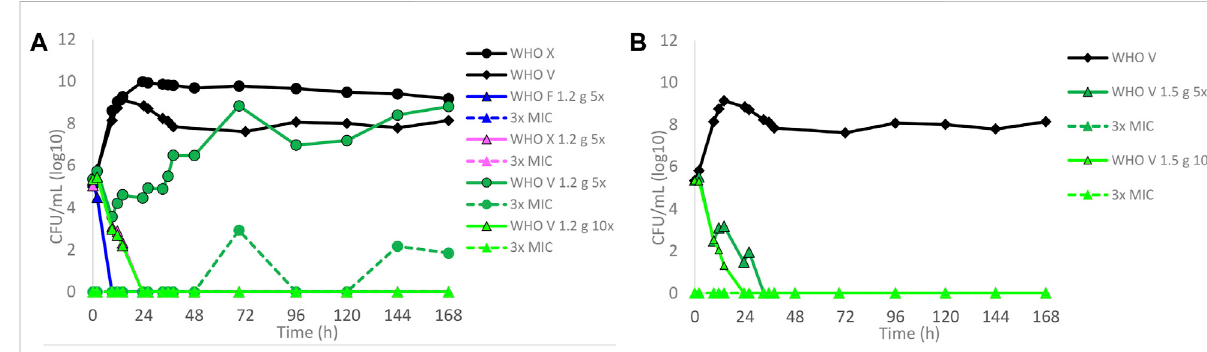
FIGURE 4 Growth curves of the total population of WHO Neisseria gonorrhoeae reference strains in hollow fi ber infection model (HFIM) experiments simulating, based on free (12% protein-unbound) lefamulin concentrations in urogenital tract tissues ( ≥ 5 – 10 times higher than in plasma) that was extrapolatedfromaratmodel(Wichaetal.,2022), (A) lefamulinoraldailydoseof1.2 gadministeredasequallydivideddosesq12hfor7 days(WHOF, X,andV)and (B) lefamulinoraldailydoseof1.5 gadministeredasequallydivideddosesq12hfor7 days(WHOV).Allexperimentswerefollowed for 7 days. The total growth of the untreated controls (black solid lines) and total growth of lefamulin-resistant populations (dashed lines) on the lefamulin-containing plates (3 ×MIC) are also shown for each treatment.